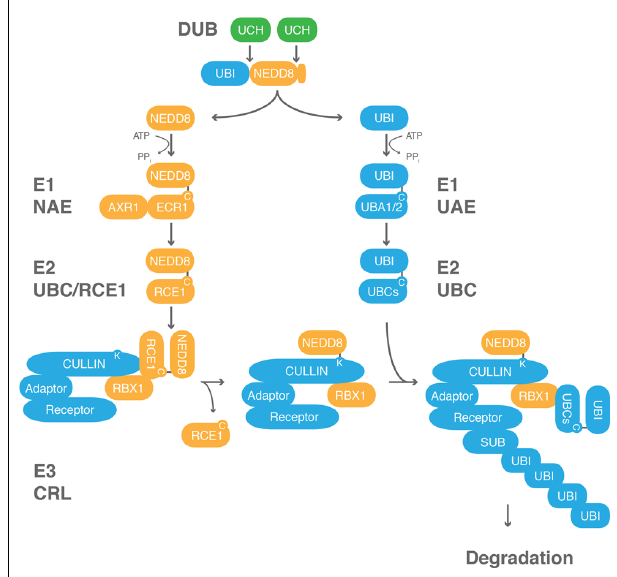
FIGURE 2 | Neddylation and ubiquitin modification are biochemically related processes. Ubiquitin c-terminal hydrolases (UCHs) belong to the family of DUBs that process ubiquitin (UBI)-NEDD8 fusion proteins. UBI and NEDD8 are activated by their conjugation to E1 ubiquitin/NAEs. UBI or NEDD8 from the E1 are then passed via a transthiolation reaction to a protein of the family of E2 ubiquitin-conjugating enzymes, RUB1 CONJUGATING ENZYME1 (RCE1) in Arabidopsis .The ubiquitin-charged E2 can then form a complex with an E3 ubiquitin ligase, and ultimately, ubiquitin and NEDD8 are transferred to a lysine residue on the cullin of the E3 and the substrate, respectively. UBI but not NEDD8 can form chains. RBX1 and other proteins not shown here are the proposed NEDD8 ligases. Cullin-RING ligases (CRLs) are the superfamily of E3 ubiquitin ligases that are regulated by neddylation. CRLs are generally composed of a cullin subunit, RBX1, as well as a substrate (SUB) recognition module composed of an adaptor and a substrate receptor protein. C, cysteine; K,